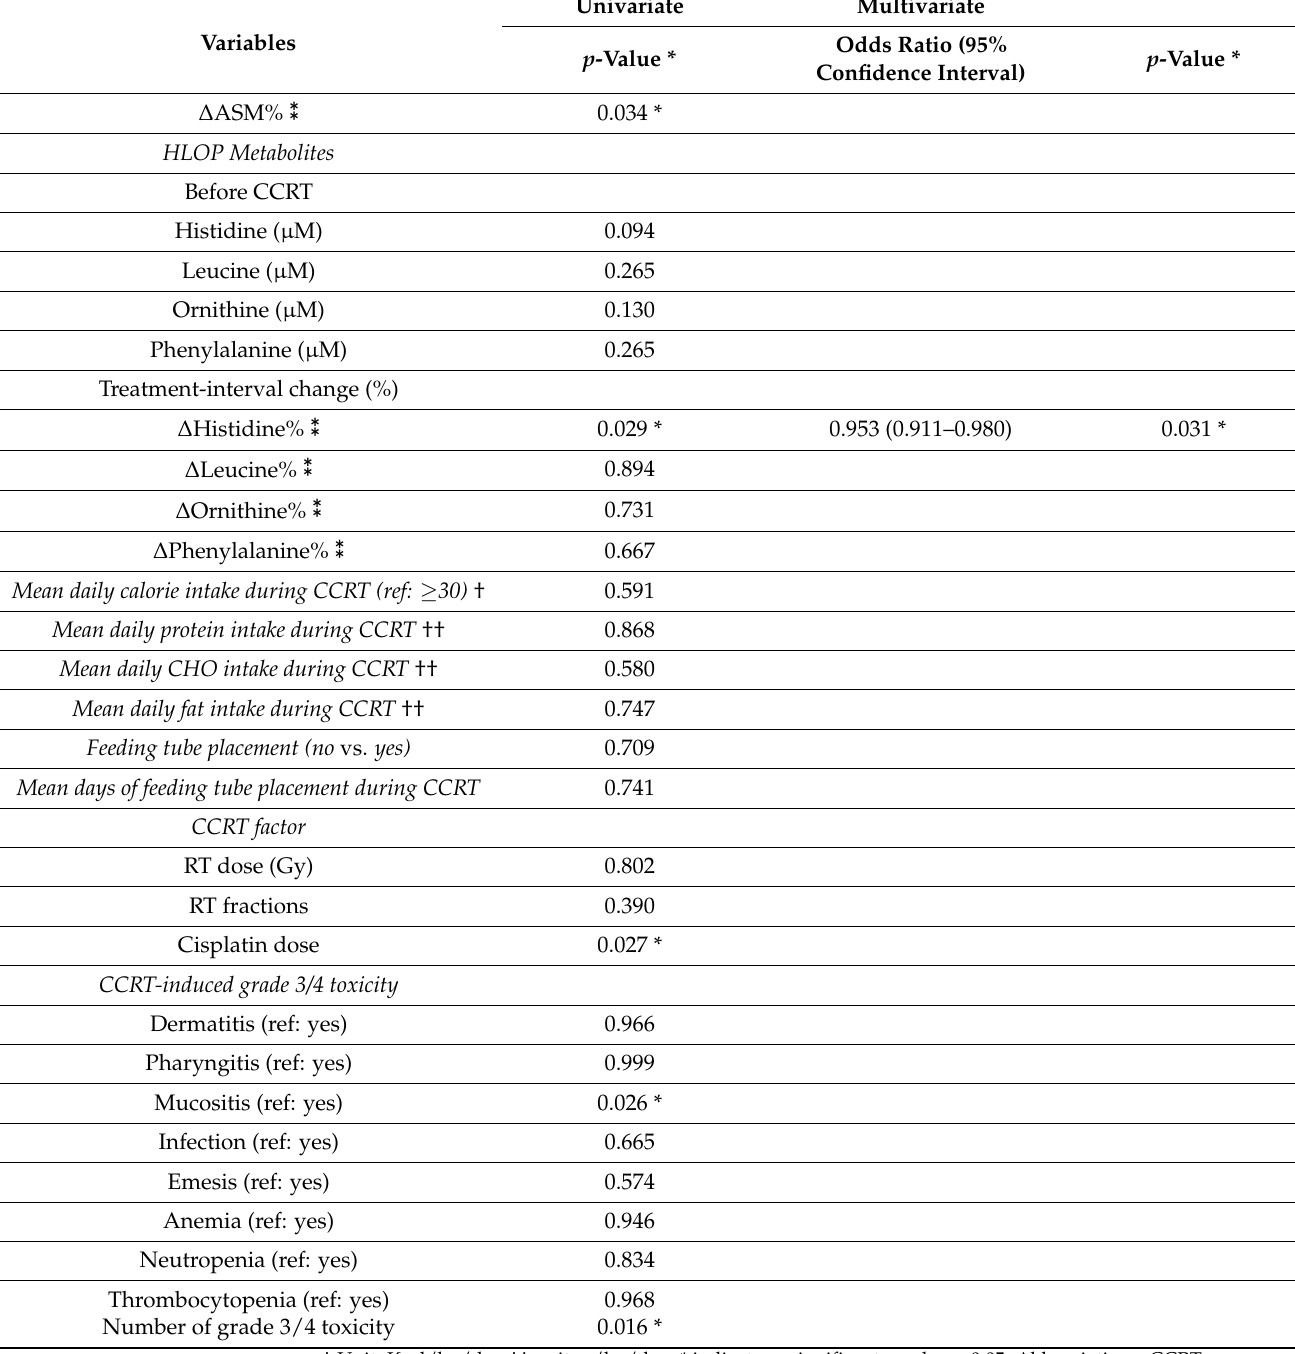
Table 1. Clinicopathological variables, biochemical and nutrition–inflammation data, anthropomet- ric and body composition characteristics, serum HLOP metabolites, and treatment-related factors of 44 patients with LAHNSCC completing the CCRT course, stratified by treatment